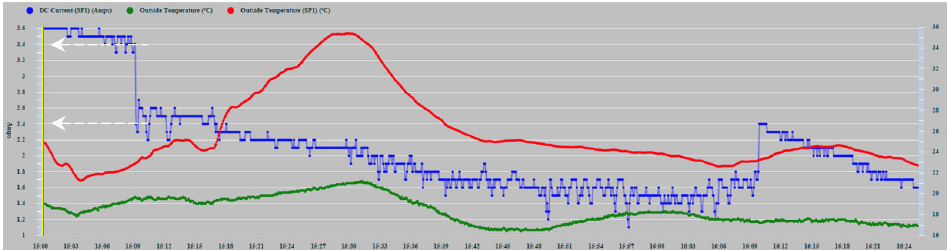
Figure 18. Effect of induced shading on an SP1 cell from 15:10 to 16:20.